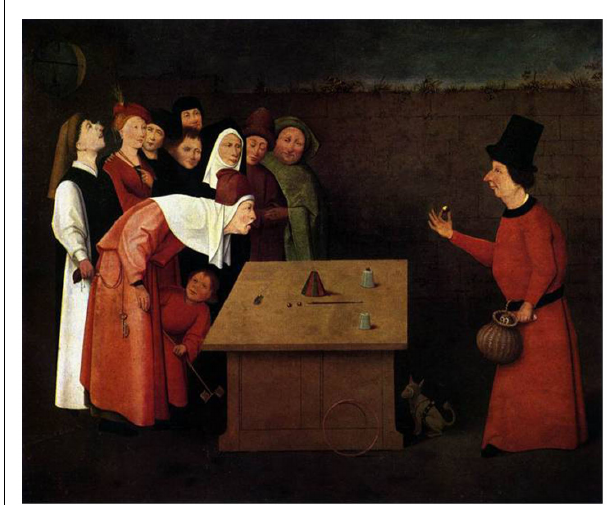
FIGURE 1 |The Conjuror by Hieronymus Bosch (estimated 1475–1505). The conjuror on the right captures his audience attention with a game of cups and balls. Cups and balls routines were first introduced more than 2000years ago and entail a host of classic effects of magic, such as vanishes, appearances, transpositions, and substitutions. Performing a cups and balls trick is highly regarded amongst magicians since it requires a great deal of motor skills and coordination, combined with an excellent audience management to effectively misdirect the spectators’ attention away from the method. In this painting, misdirection is so powerful that the spectator in the forefront, mesmerized by the conjuror’s performance, fails to notice that someone standing behind him is stealing his